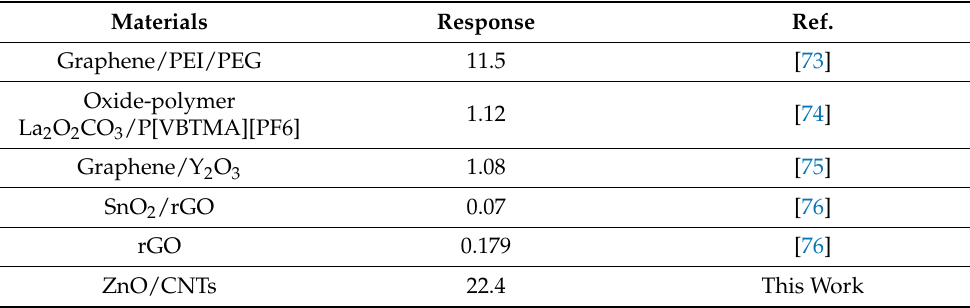
Table 2. Performance parameters for many nanomaterials for detection of CO 2 gas reported in this review and previous